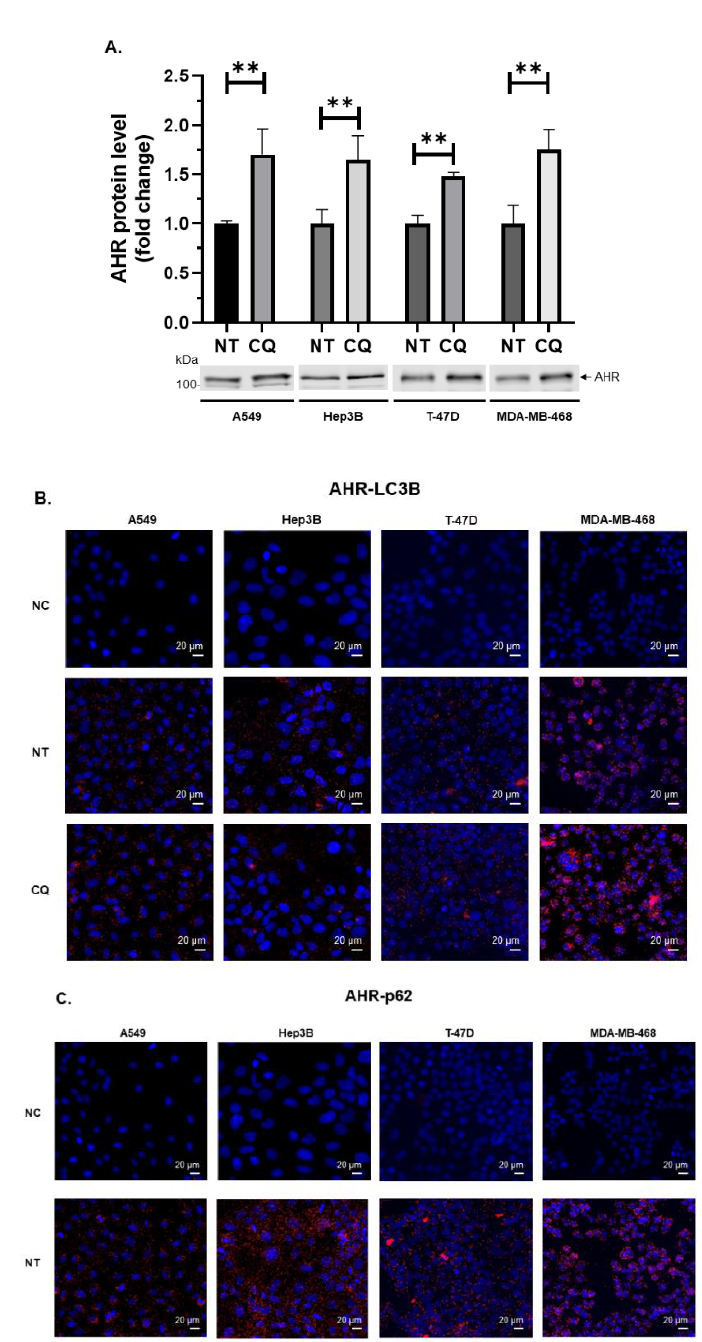
Figure 7. AHR is degraded via autophagy in human lung, liver, and breast cancer cell lines. ( A ) Treatment of 40 µ M CQ dissolved in water for 6 h increased AHR protein levels in A549, Hep3B, T-47D, and MDA-MB-468 cells (means ± SD; n = 3 of one experiment, except for n = 5 for Hep3B). This experiment was repeated once with similar results. Each Western lane contained 30 µ g of whole-cell lysate. Data are normalized by the total protein stain. NT, no addition as no treatment. An unpaired t -test was used to determine statistical significance. The images below are representative of the replicate data. Proximity ligation assay results showing that AHR interacted with ( B ) LC3B and ( C ) p62 in all four cell lines. All images are representative of the replicate data of three independent experiments. Each image contains a scale bar at the right bottom. NC, negative control (cells incubated without primary antibodies against interaction partners); NT, no addition as no treatment; CQ, chloroquine in water.